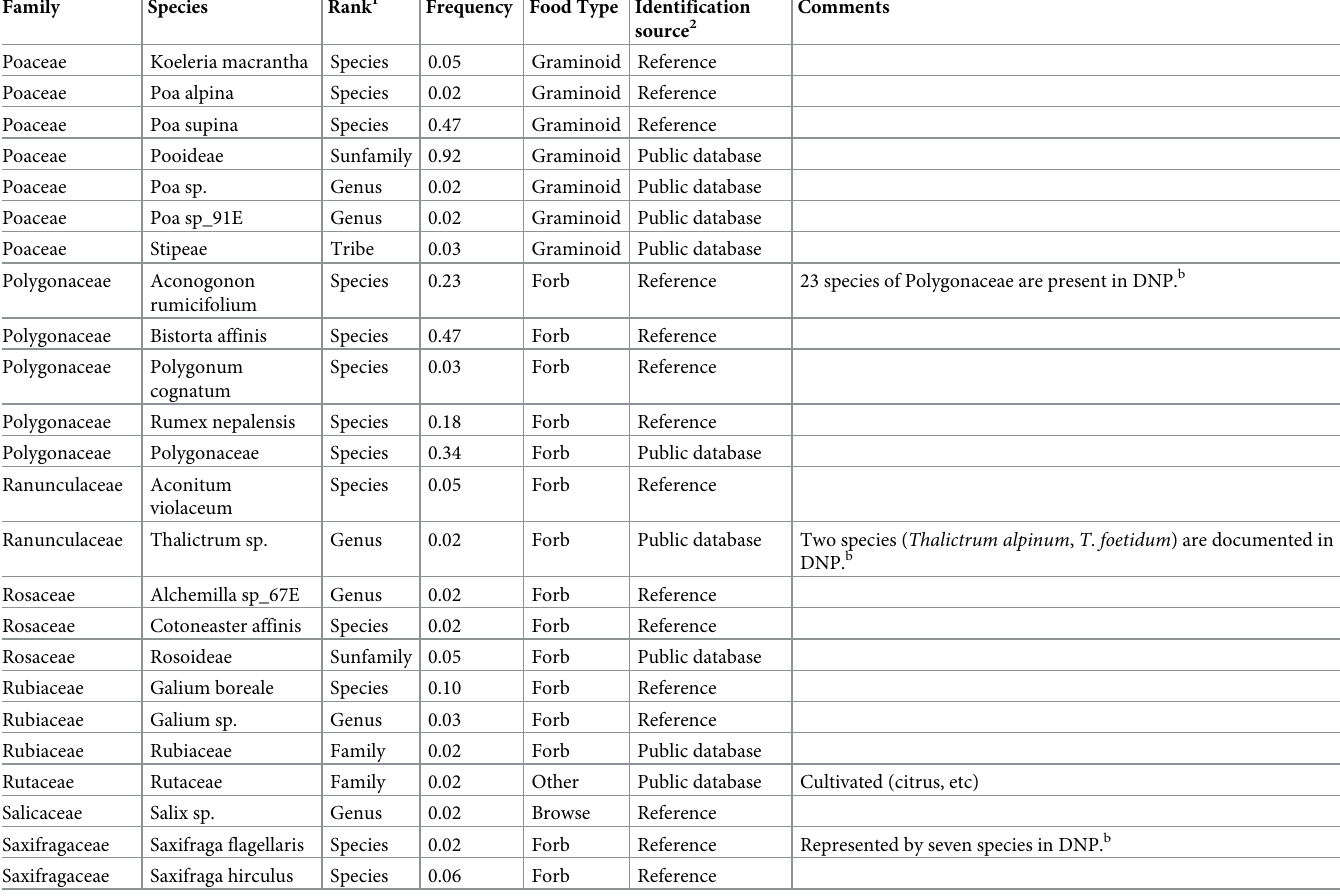
Scat analysis of 43 samples, for which sex was known (Fig 2), indicated that the foraging behav- ior of the sexes was quite similar, except for rodents (P = 0.02, the Fishers’s exact test). Females’ likelihood of eating rodents was 84% lower than that of males (Odds ratio: 0.16). Among the 62 fecal samples analyzed by the trn L approach, 21 belonged to females, 37 to males, and for 4 sex was not known. We identified 34 and 43 species from female and male samples, respectively. The ratio of graminoids to forbs did not differ significantly ( χ 2 : 0.24, P = 0.63) among sexes. Comparing individual species, the Fisher’s exact test indicated signifi- cant differences in three plant species. The likelihood of eating Bistorta affinis (Odds ratio = 0.30, P = 0.02), Carex diluta (Odds ratio: 0.34, P = 0.03), and Carex sp. (Odds ratio: 0.24, P = 0.01) was significantly higher for